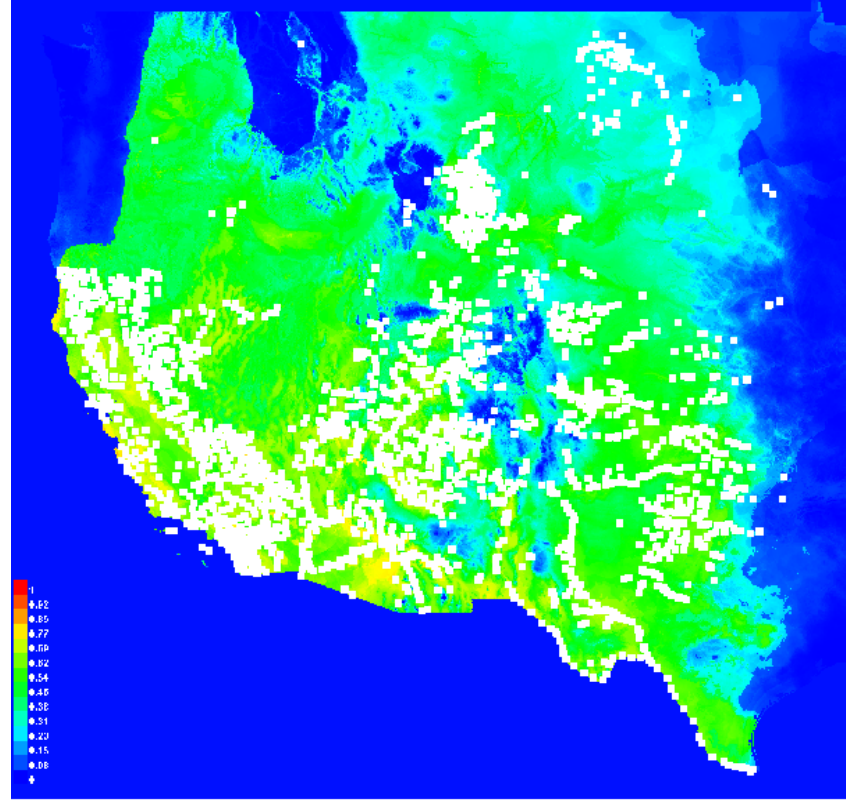
Figure 5. The model output for Tamarix in the western United States.